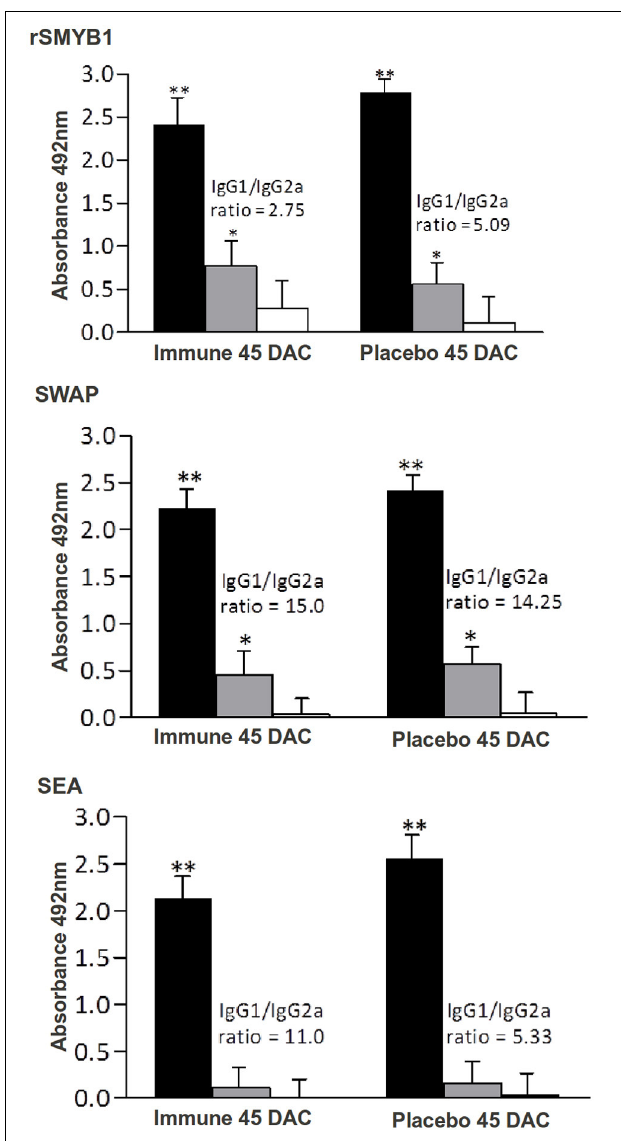
FIGURE 7 | Kinetics of specific anti-rSMYB1, anti-SWAP and anti-SEA IgG, IgG1, and IgG2a antibodies. The presence of antibodies was measured in sera from 10 mice immunized with Tris-NaCl + adjuvant (placebo group) or with rSMYB1 + adjuvant (immune group). Sera were collected prior to sacrifice 45 days after challenge and assayed by ELISA. The results are presented as the mean absorbance at 492nm for each immunoglobulin isotype. Asterisks indicate statistically significant differences between the vaccinated and pre-immune groups: ∗ p < 0 . 05, ∗∗ p < 0 . 01. DAC, days after challenge. Black bars: IgG antibody. Gray bars: IgG1 antibody. White bars: IgG2a antibody. The results are representative of two independent biological